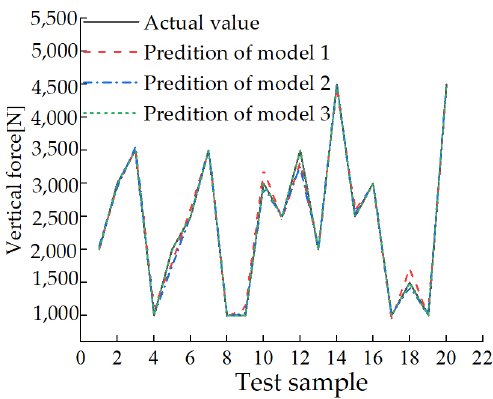
Figure 32. The vertical force prediction results of the three models.